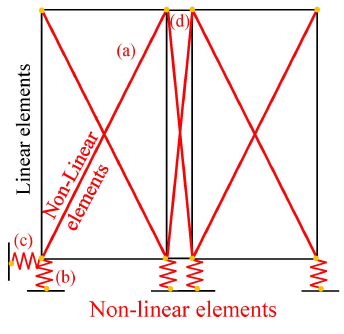
Figure 11. Finite Element model of Wall A for model validation. Table 4. Main parameters of non-linear springs representing the connections.